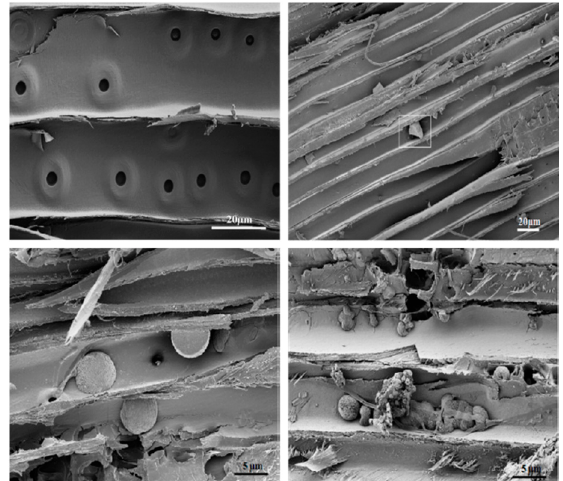
Figure 5. Scanning electron microscopic (SEM) images of control wood block (top-left), wood blocks treated with CC formulations (top-right), leached wood blocks treated with OK / CC (bottom-left) and OK / CC / B (bottom-right) formulations with permission from Elsevier [20].